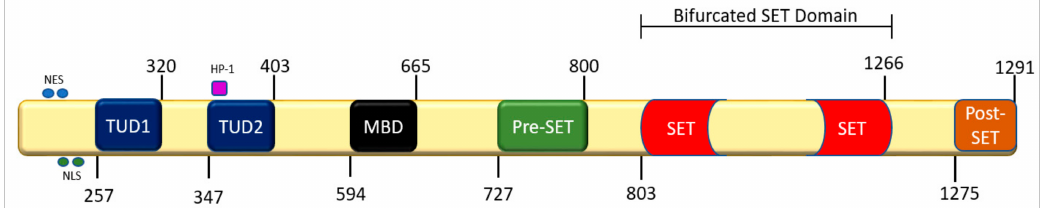
Figure 2. Schematic of SETDB1 domains inclusive of amino-acid location. Blue circles = Nuclear Export Sequence (NES), green circles = NLS (nuclear recognition sequences), purple square = heterochromatin protein-1